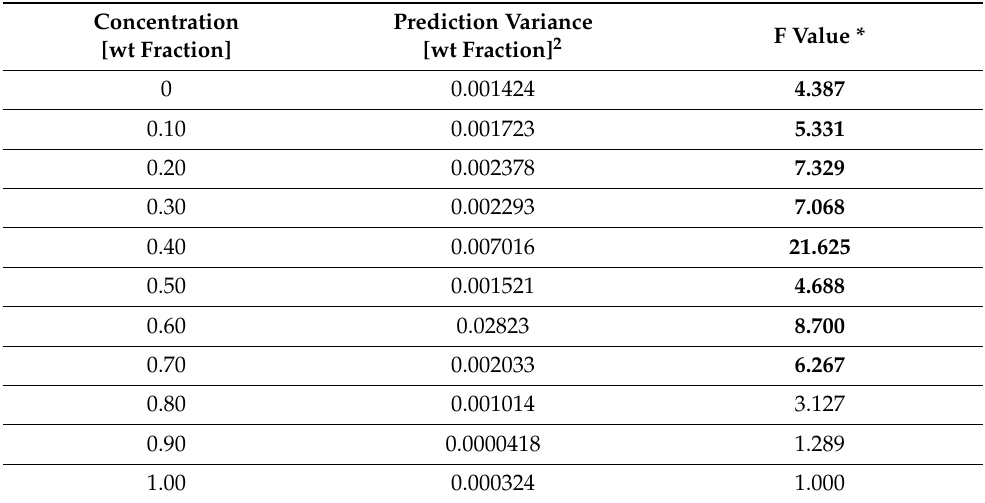
Table 2. Data for error prediction for different xylene concentrations at 90 ◦ C and 450 rpm using H-PCR method.